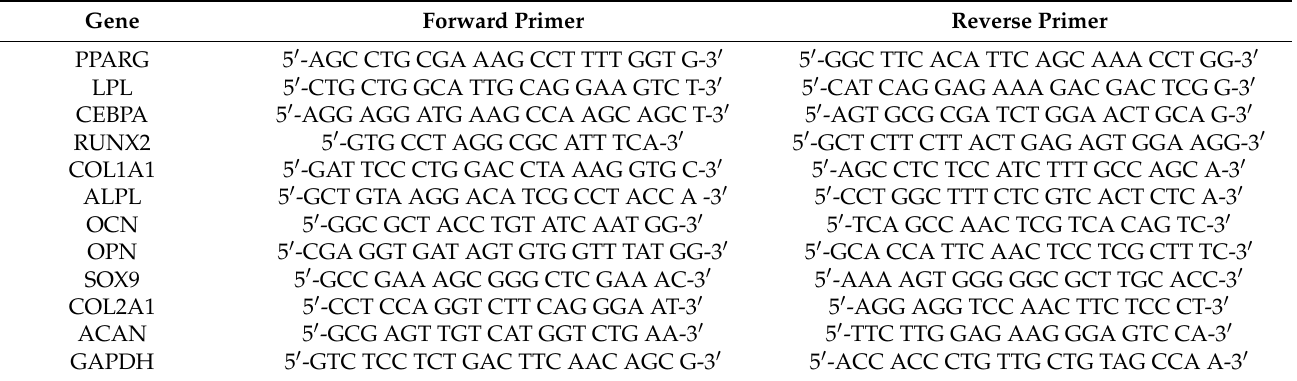
Table 1. List of primers.